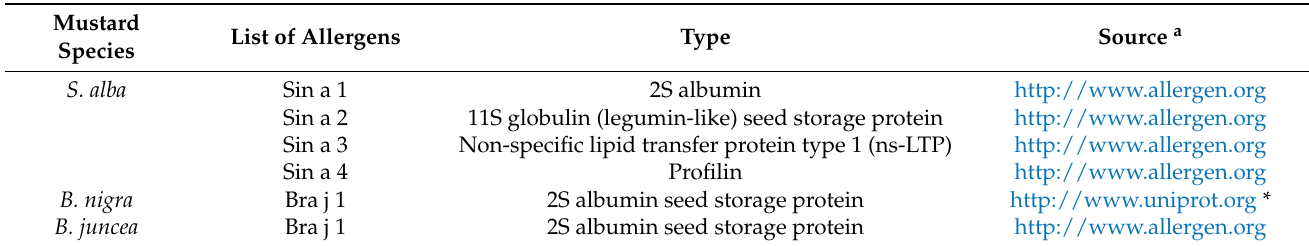
Table 5. Mustard